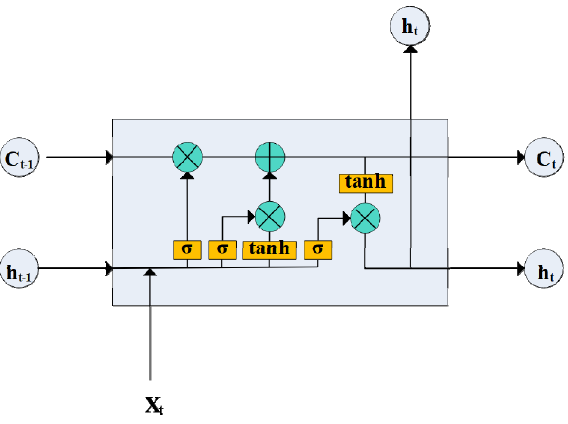
Figure 1. LSTM model core structure diagram.